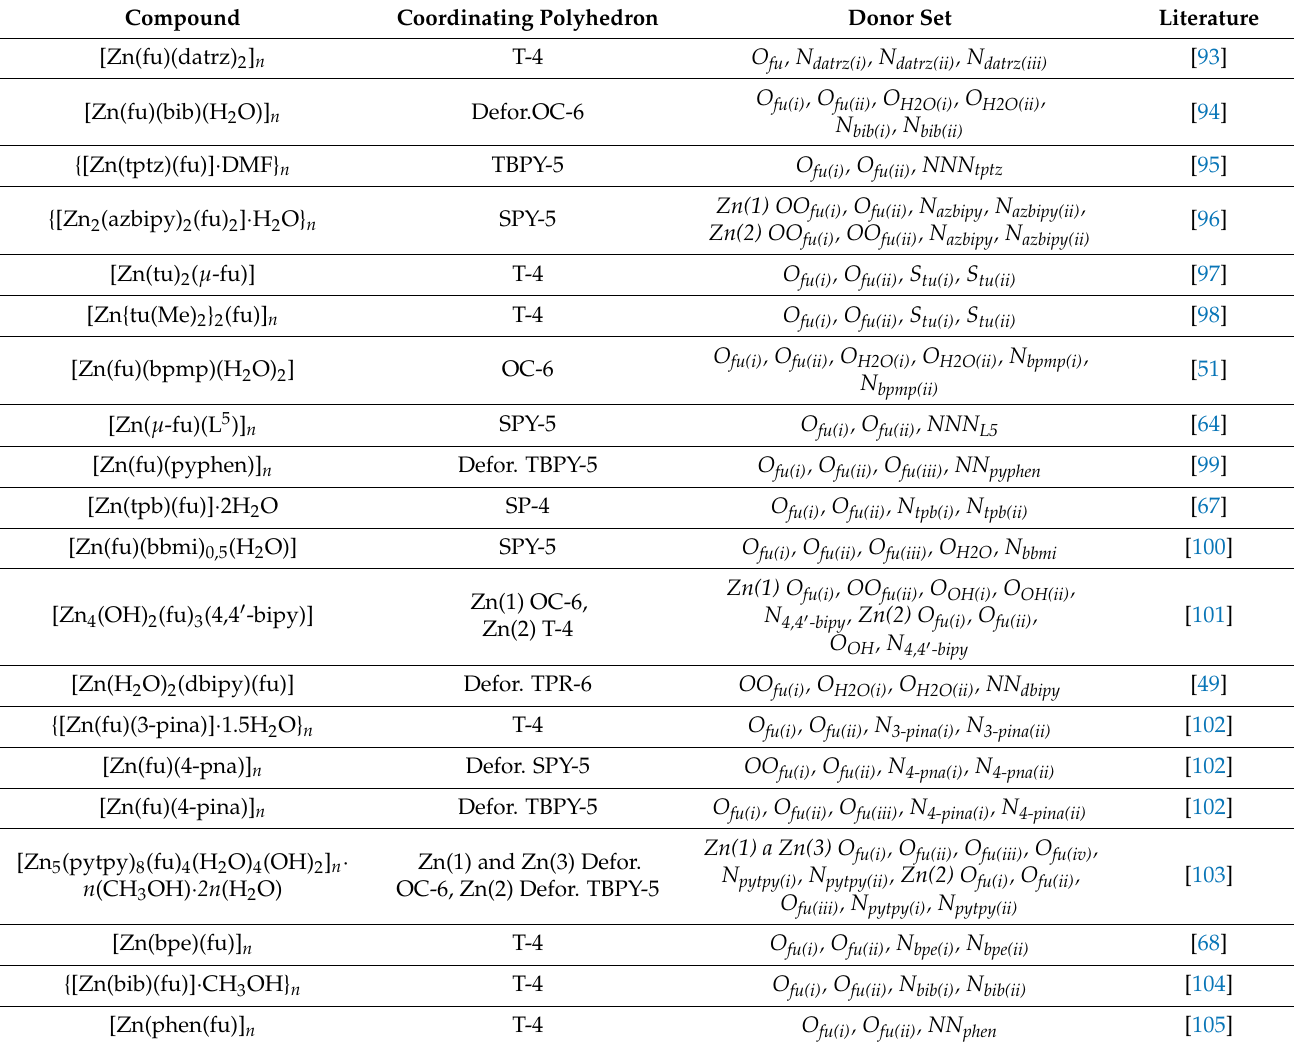
Table 7. Assigned coordination polyhedra and donor sets to structurally characterized zinc complexes with fumaric acid and N donor